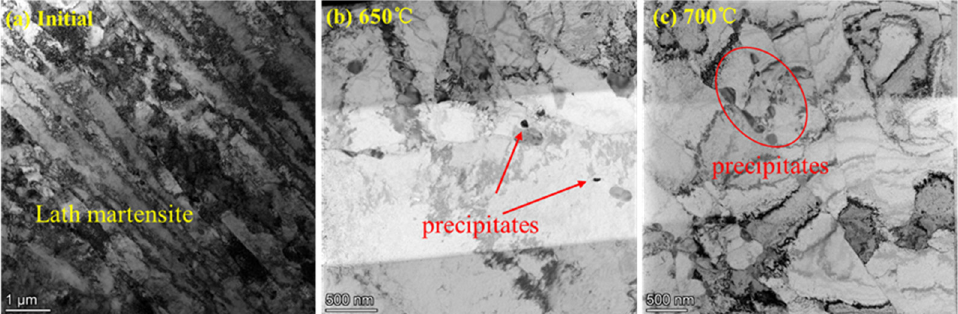
Figure 7. TEM morphological images of T91 steel for ( a ) initial microstructure, ( b ) 650 °C, and ( c ) 700